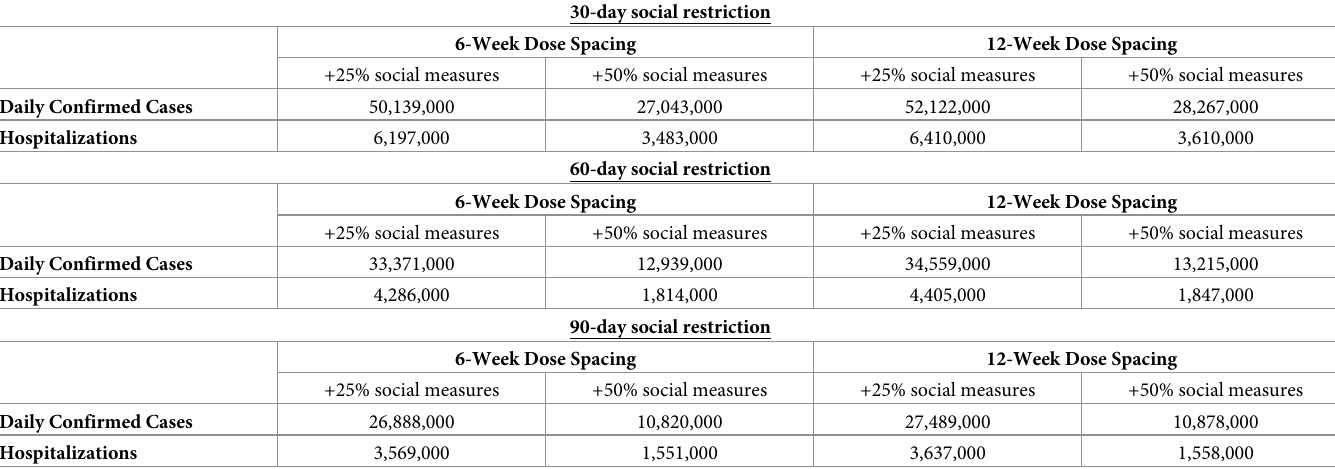
Table 3. Forecasted cumulative confirmed cases and hospitalizations from May 5 th 2021 to December 29, 2021, given 6-week and 12-week dose spacing (after July 1st). All simulations include a biweekly ramp of vaccination to 3x the rate just prior to May 5 th